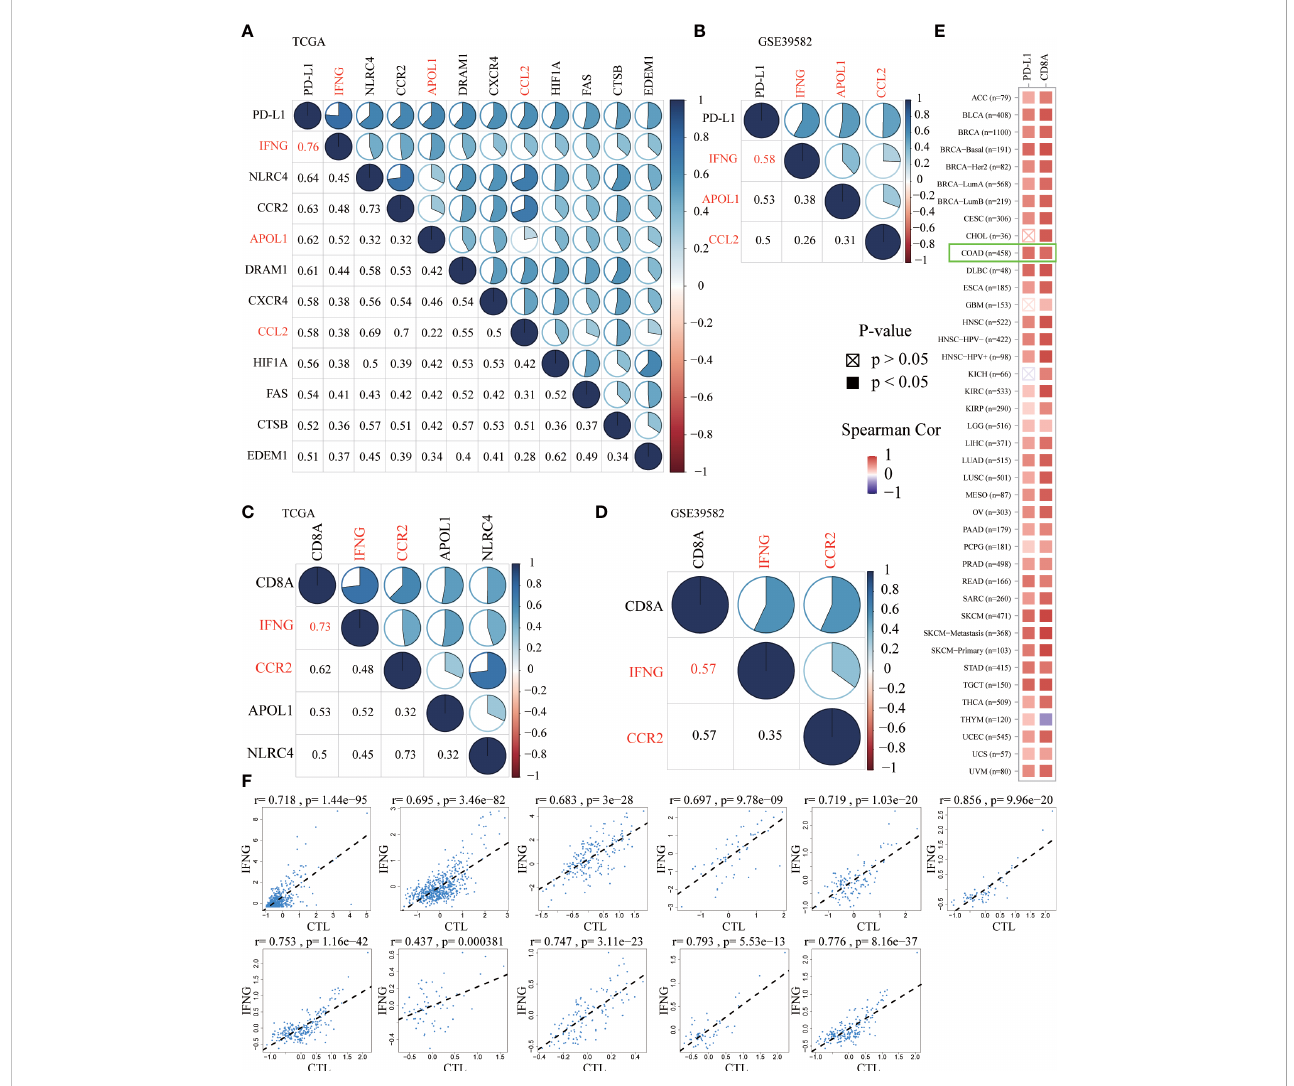
FIGURE 4 The Spearman correlation analysis of autophagy-related genes (ARGs) with PD-L1 (A, B) and CD8A (C, D) in the TCGA and GSE39582 (Spearman correlation coef fi cient > 0.5). The shared ARGs were marked in red. Blue represented positive correlation while red represented negative correlation. The darker the color, the greater the correlation. The numbers in the lower left corner and the pie chart in the upper right corner of the correlation graph represented the Spearman correlation coef fi cient in different forms. (E) On the TIMER2.0 website, in pan-cancer, we con fi rmed the general correlation between IFNG and PD-L1 and CD8A. (F) On the TIDE website, based on various public cohorts, IFNG expression was signi fi cantly and positively correlated with cytotoxic T lymphocyte (CTL)